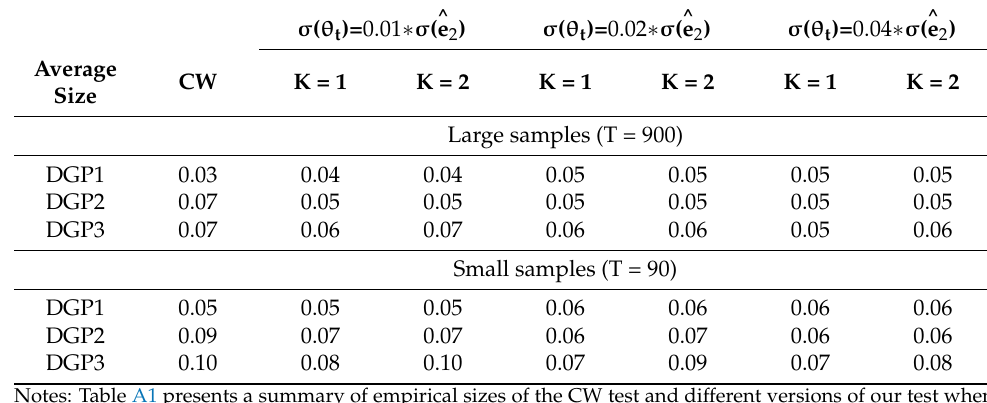
Table A1. Summary of empirical size comparisons between CW and WCW tests with nominal size of 5% for our three DGPs.